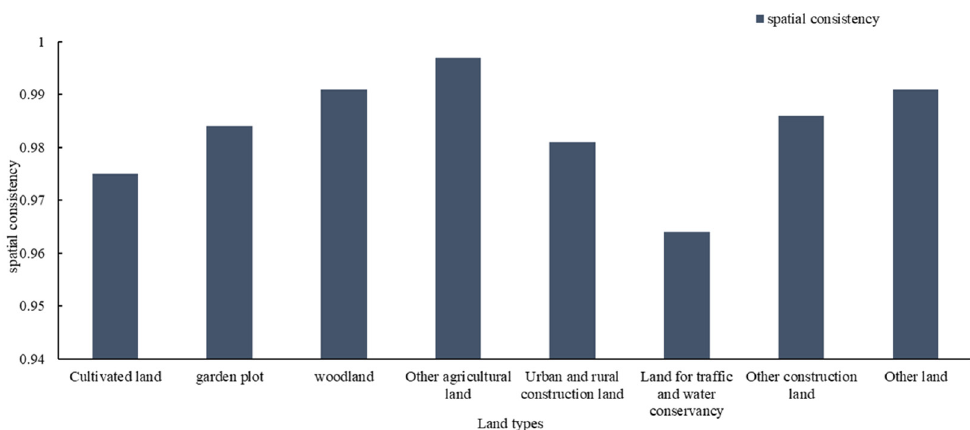
Figure 3. The spatial consistency of different types in the implementation process of the Rongchang District plan in 2015.